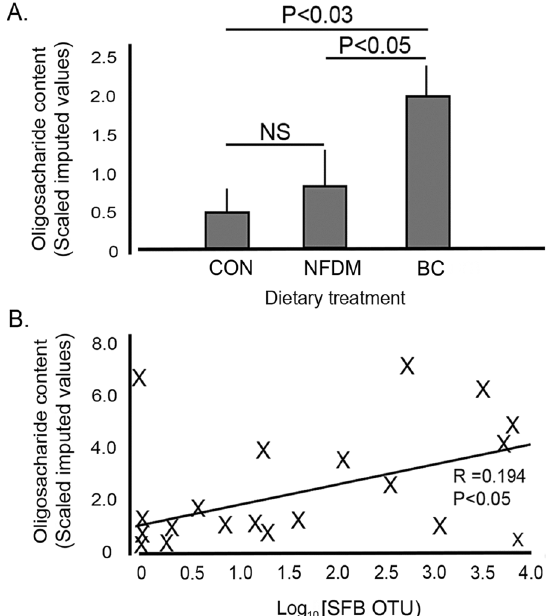
Fig. 7 Sialyllactose content of ileal digesta is correlated with presence of SFBs. Ileal digesta content of the combined mean ( SEM) levels of the 3 ′ -sialyllactose and 6’-sialyllactose represented ± as the metabolomic Scaled Imputed Values as measured in samples from chickens fed the three diets (Panel A ). Summated 3 ′ -sialyllactose and 6 ′ -sialyllactose values were regressed on the Log10 [OTU of the SFB] yielding a significant positive linear correlation. (Panel B